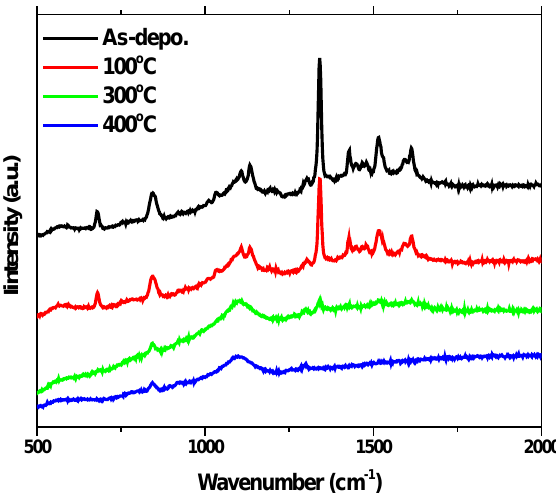
Figure 5. Raman spectra of FCrPc deposited and treated with different temperatures.